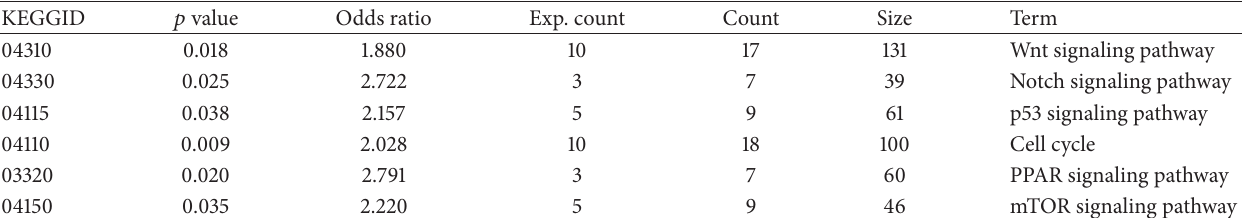
Table 4: Gene pathways based on the KEGG classification of a similar expression in CD 34 − stem cells from umbilical cord blood and CD 34 − cells from bone marrow for clusters 1–8, 10–12, and 14-15. KEGGID 𝑝 value Odds